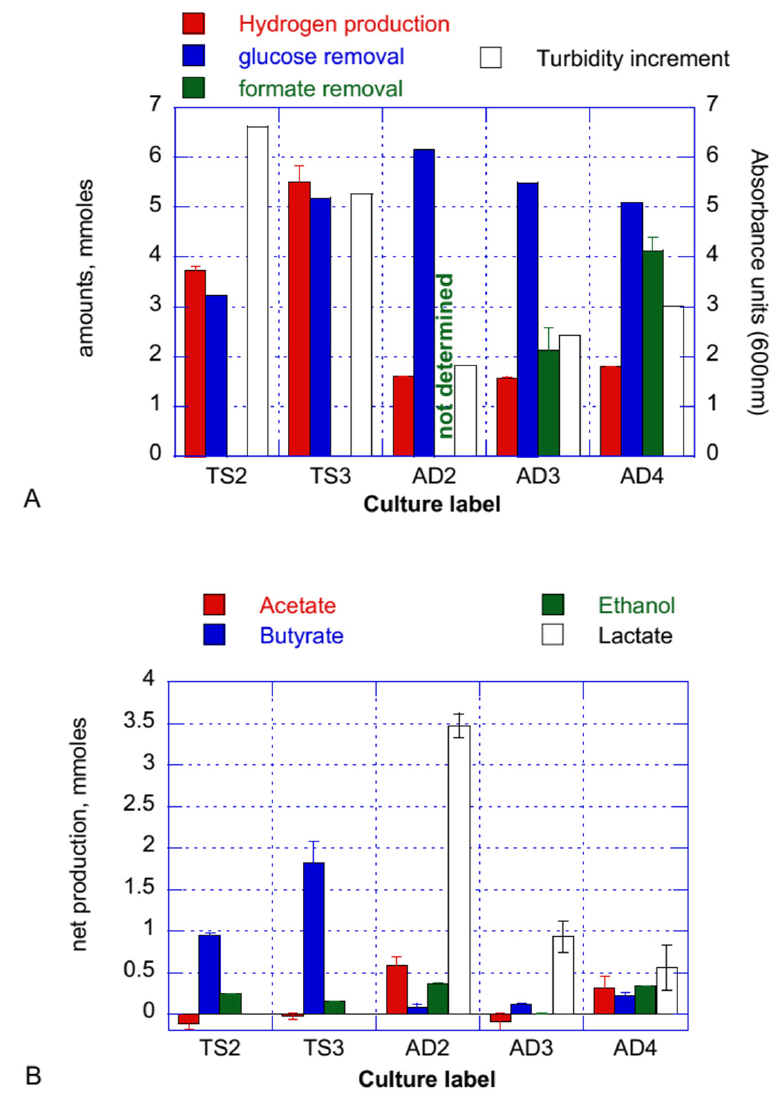
Figure 2. ( A ) Overall substrate removal (mmol), hydrogen production (mmol), and turbidity (AU at 600 nm) increment; ( B ) net increase in soluble end products (mmol) in the five cultures at the end of biogas production (error bars represent standard deviations; negative values in ( B ) are due to initial presence of soluble end products carried by the inoculum from the preceding culture).